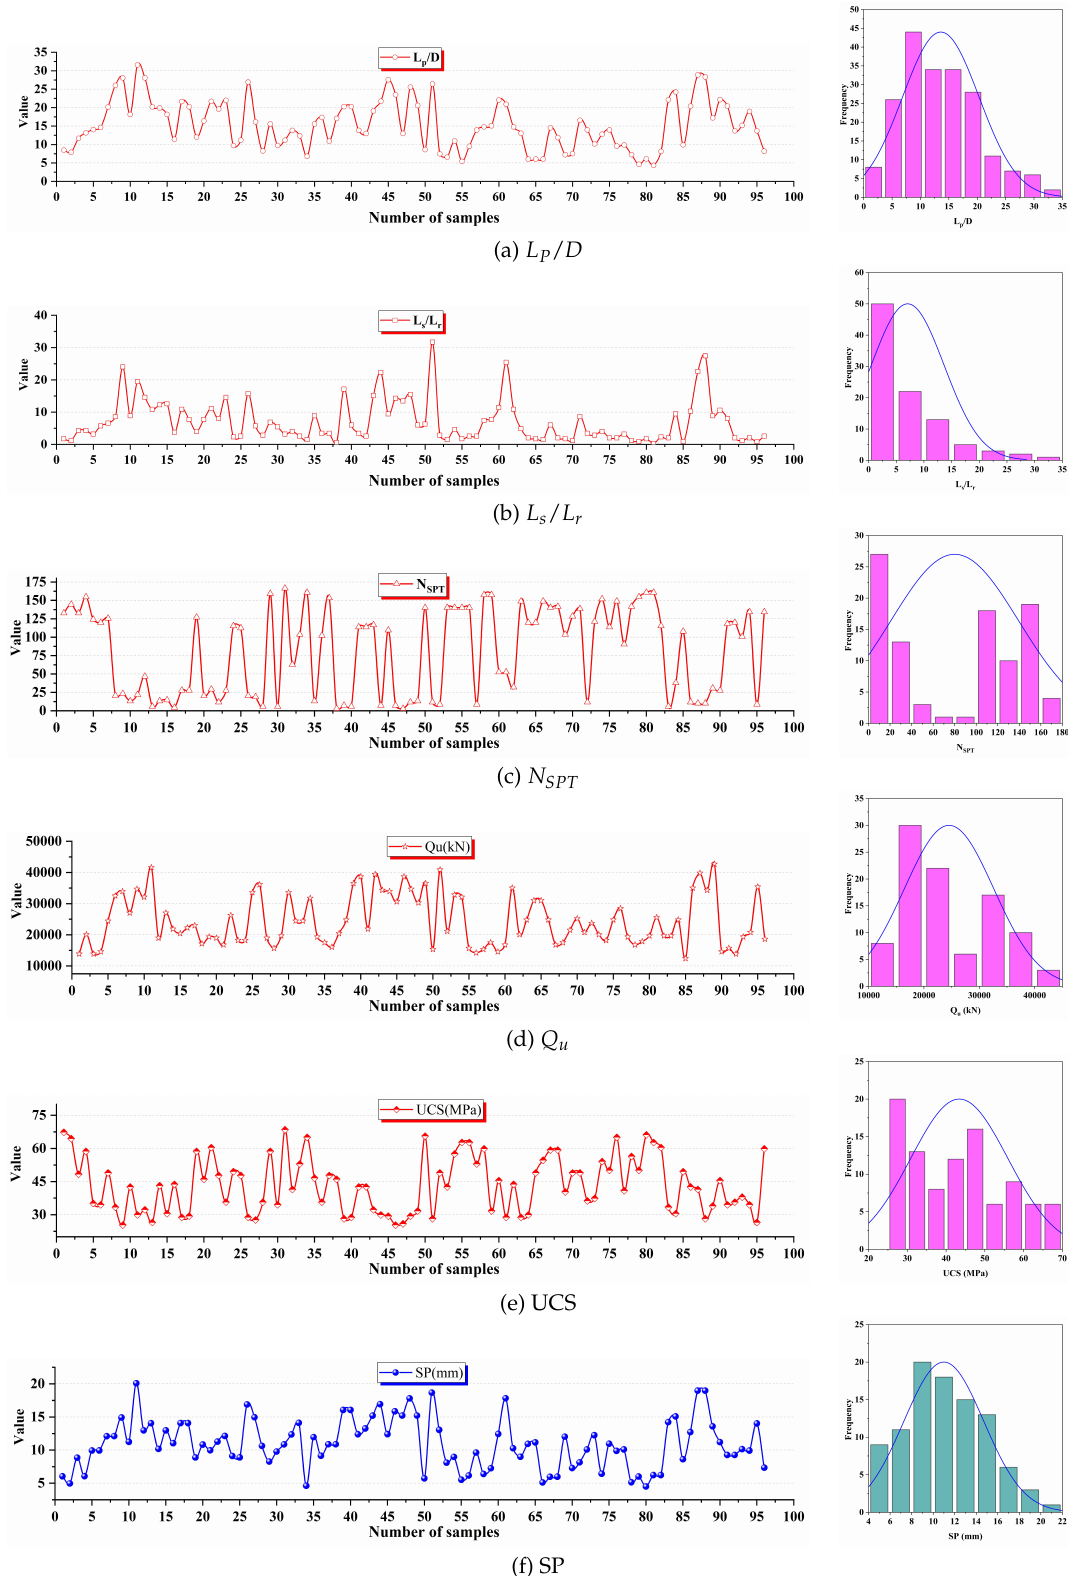
Fig. 2. The dataset distribution and their histogram